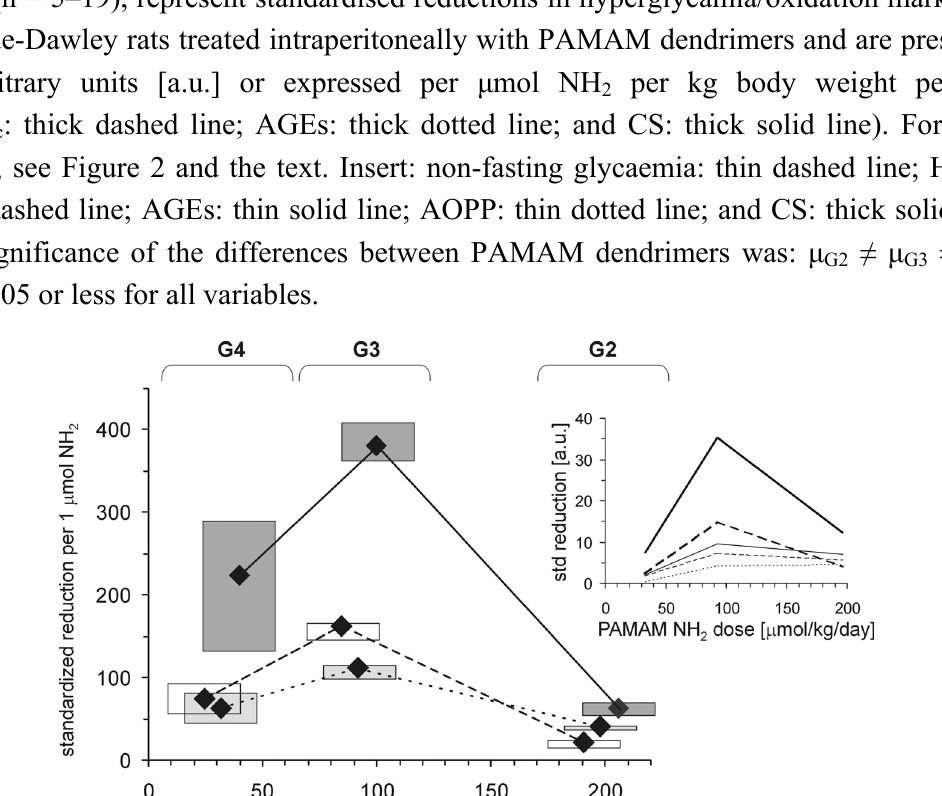
per kg body weight per day 2 : 1c ≠ μ ≠ μ , G2 G3 G4